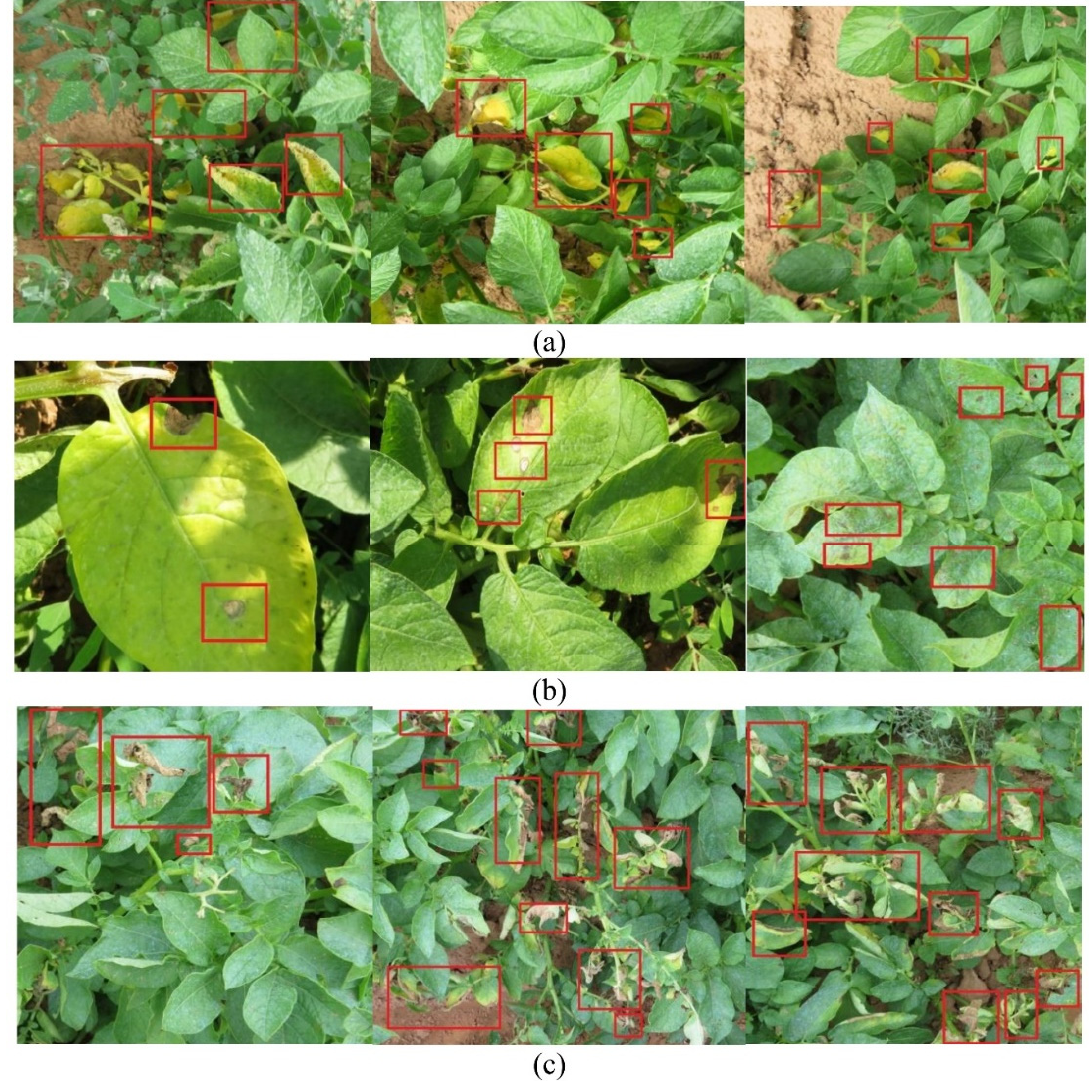
Figure 1. Sample images for identification of early blight disease stages on potato leaves; ( a ) pale yellow color leaves at the initial stage of the disease, ( b ) concentric brown circles in the leaves at mid-stage, and ( c ) senescence of leaves at the last stage of the disease.